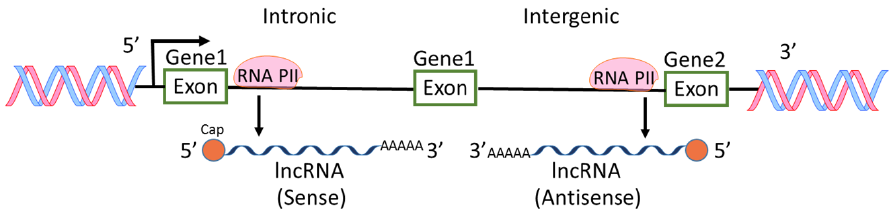
Figure 2. Biogenesis of lncRNAs. lncRNAs are transcribed by RNA polymerase II (RNA PII) intronically and intergenically. The sequences of lncRNAs are either sense or antisense compared to protein-coding genes.